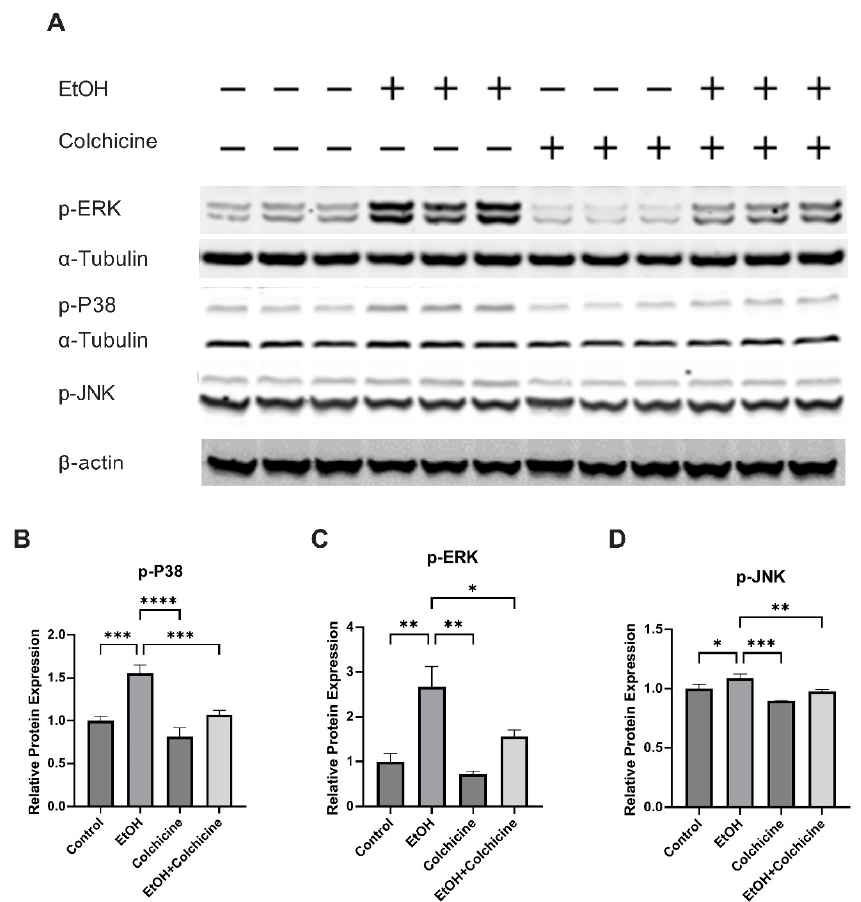
Figure 4. Colchicine inhibited mitogen activated protein kinases (MAPKs) activation: ( A ) Western blots for proteins of p-P38, phosphorylated extracellular signal-regulated protein kinase (p-ERK), and phosphorylated c-Jun N-terminal kinase (p-JNK). Colchicine averted relative protein expression of ( B ) p-P38, ( C ) p-ERK, and ( D ) p-JNK in ethanol-treated endothelial cells. α -Tubulin was used as a loading control for all proteins expression except p-JNK. β -actin was used as a loading control for only p-JNK on a separate membrane. The experiment was performed with independent biological triplicates. The data was analyzed by performing one-way ANOVA followed by Tukey’s test. Error bars represent the SD (**** p < 0.0001, *** p < 0.001, ** p < 0.01, and * p <